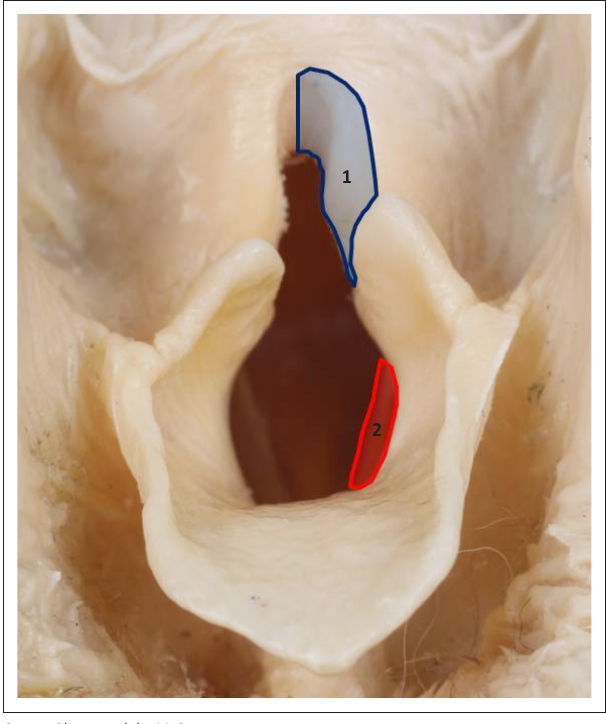
TABLE 1: Surgical treatment methods with their reported percentages of improvement, aspiration pneumonia, minor complications (persistent stridor, coughing, gagging, panting, seroma formation, exercise intoler ance or vomiting), webbing and mortality rate. Treatment method